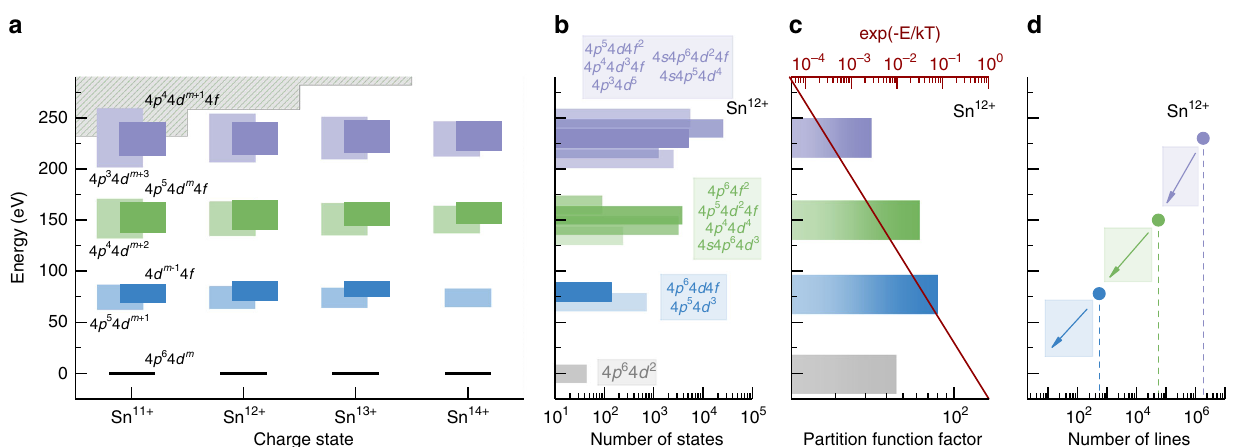
Fig. 2 Energy levels of tin ions and their population. a Schematic energy level diagram of the ions Sn 11 + – Sn 14 + , showing only selected Δ n = 0 transitions for clarity. The ground-state con fi gurations of these ions take the form 4 d m , with m = 3 − 0. The lowest-lying level of each ground-state manifold is shown in black and is fi xed at an energy of 0 eV. The energy "spread'' of an excited con fi guration is illustrated by a rectangle, centered at the average energy of the con fi guration and whose width represents the fi rst moment of the level distributions. The shaded gray area denotes the ionization potentials of the ions. For P ð 2 J þ 1 Þ per con fi guration. c Partition function factor, de fi ned as the Sn 12 + ion example case: b Statistical weight J con fi gurations i grouped by excitation degree and (in red) exponential Maxwell – Boltzmann weighting factor exp ð(cid:2) E = kT Þ with T = 32 eV. d Number of lines per grouped con fi guration. In the fi nal calculations, more excitations from further Δ n = 0 permutations and excitations into the n = 5 shell are also considered, resulting in a total of 10 10 dipole allowed transitions.